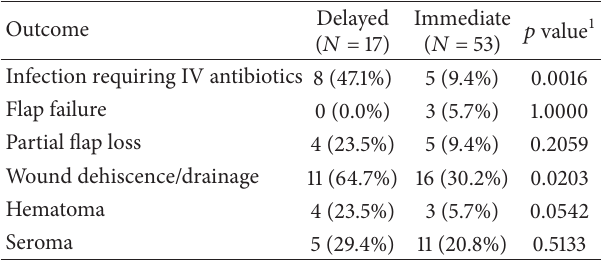
Table 2: Flap type. Table 3: Outcomes by reconstructive type